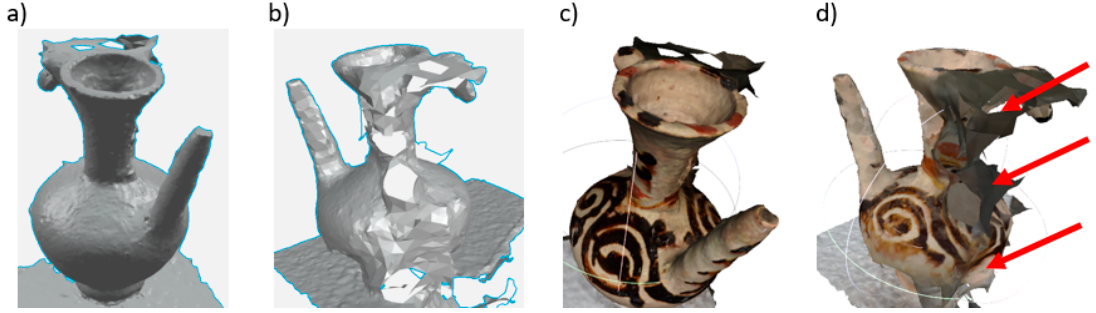
Figure 9. The appearance of a digital model of a jug with SfM: ( a , b ) without texture—side one and two, ( c , d ) with texture— side one and two. Option 2 —using photos after processing, Figure 10.